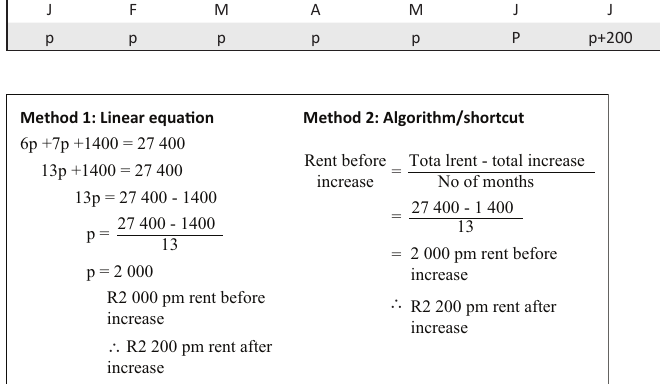
FIGURE 17: Rent calculation given increase in amount.